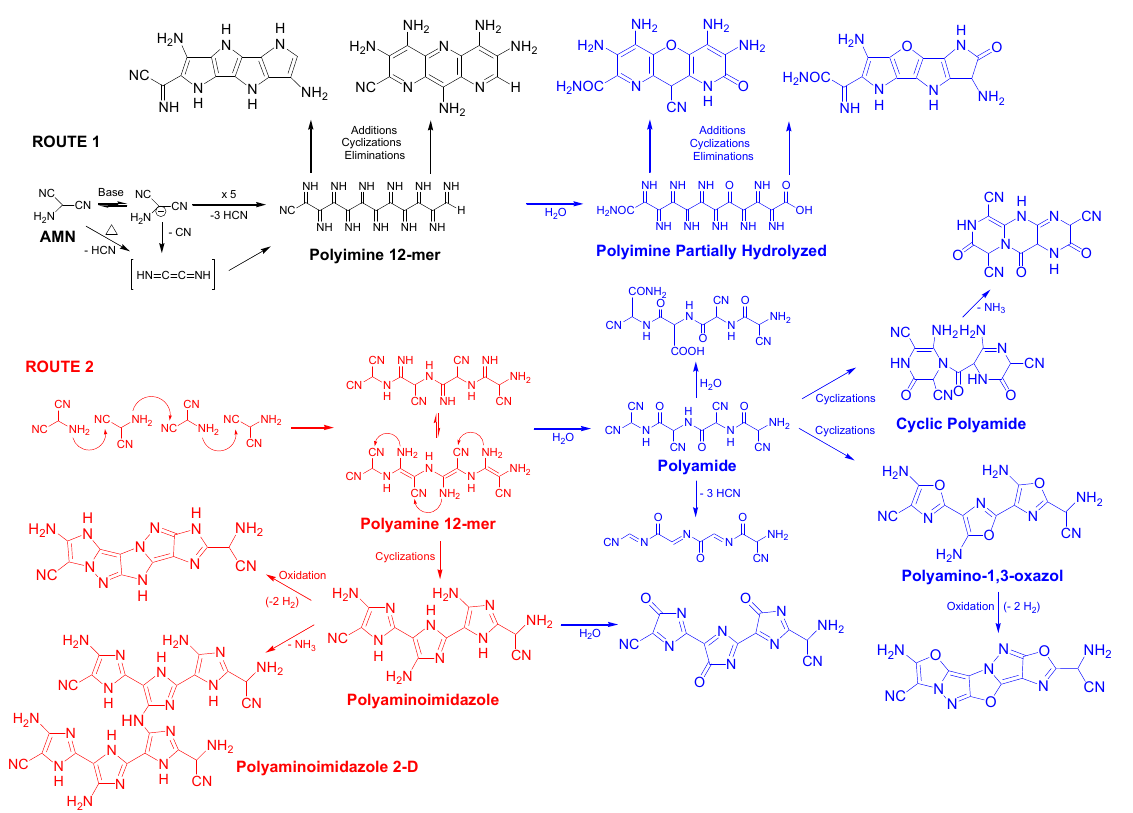
Scheme 4. Hypothetical pathways for the formation of HCN polymers from amino-nalano-nitrile (AMN) with linear growth according to recent works in the literature [115,117,138].